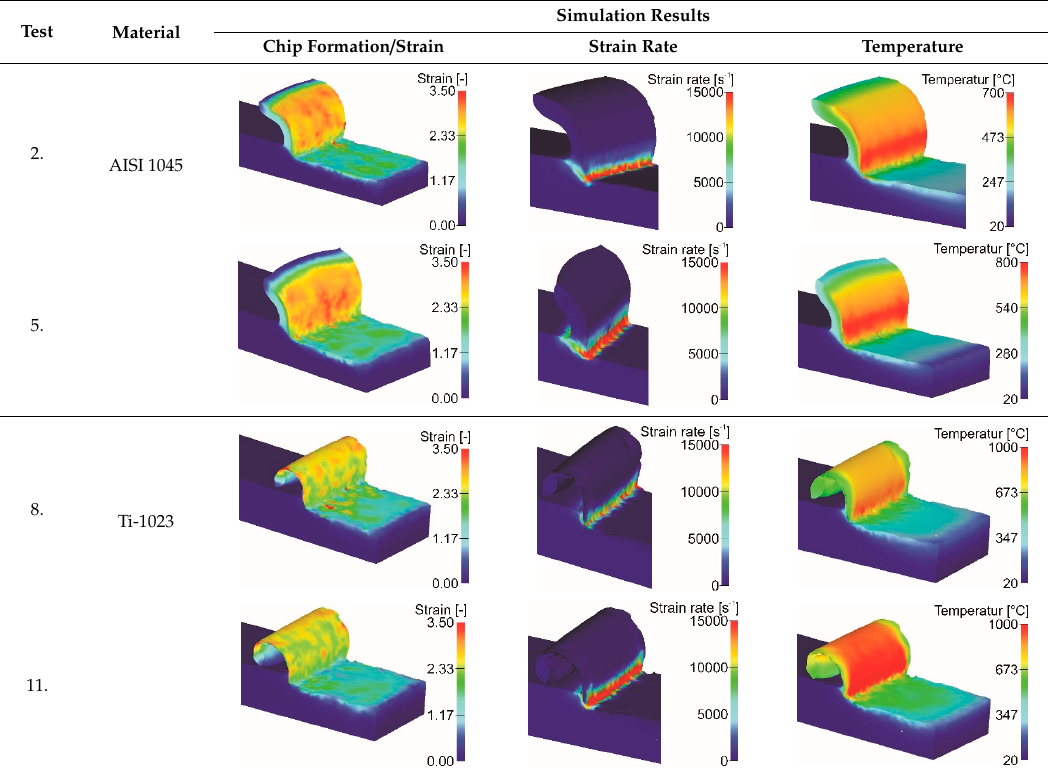
Table 3. Exemplary simulation results of the chip morphology, the strain rate in the shear zones and the temperature flows in the workpiece.